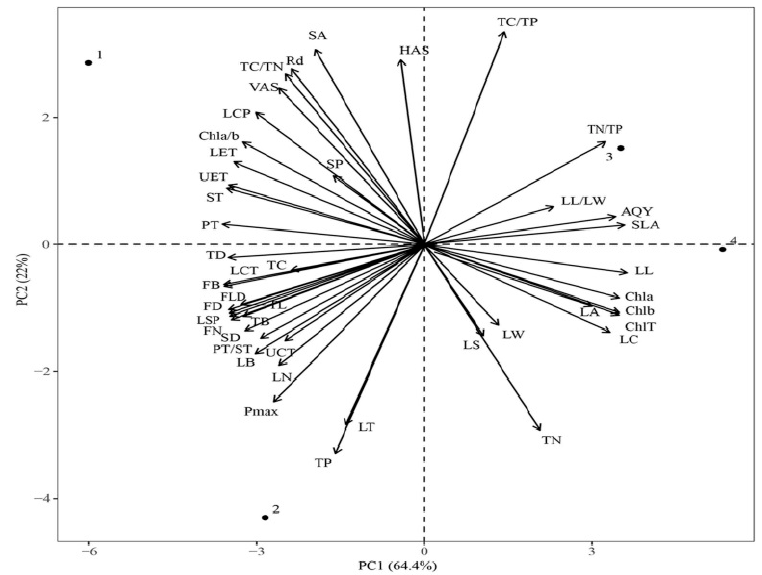
Figure 9. Principal component analysis (PCA) of functional traits of C. oleifera under different light regimes. Note: Parameters include CK: 100% light regime (1); HL: 75% light regime(2); ML: 50% light regime(3); LL: 30% light regime(4), leaf length (LL), leaf width (LW), leaf length/leaf width (LL/LW), leaf area and circumference (LA and LC), specific leaf area (SLA), and leaf thickness (LT); upper cuticle thickness (UCT), lower cuticle thickness (LCT), upper epidermis thickness (UET), lower epidermis thickness (LET), palisade tissue thickness (PT), spongy tissue thickness (ST), and palisade tissue thickness/spongy tissue thickness (PT/ST); horizontal axes of stomata (HAS), vertical axes of stomata (VAS), stomatal density (SD), stomatal area (SA), and stomatal perimeter (SP); chlorophyll a content (Chl a), chlorophyll b content (Chl b), total chlorophyll content (Chl T), chlorophyll a/b content (Chl a/b), TC, TC/TN, TN, TC/TP, TP, and TC/TP; light saturation point (LSP), light compensation point (LCP), net photosynthetic rate (Pmax), apparent quantum yield (AQY), and dark respiration rate (Rd), twig diameter (TD), twig length (TL), leaf number (LN), twig biomass (TB), fruit diameter (FD), fruit longitudinal diameter (FLD), fruit number (FN), and fruit biomass